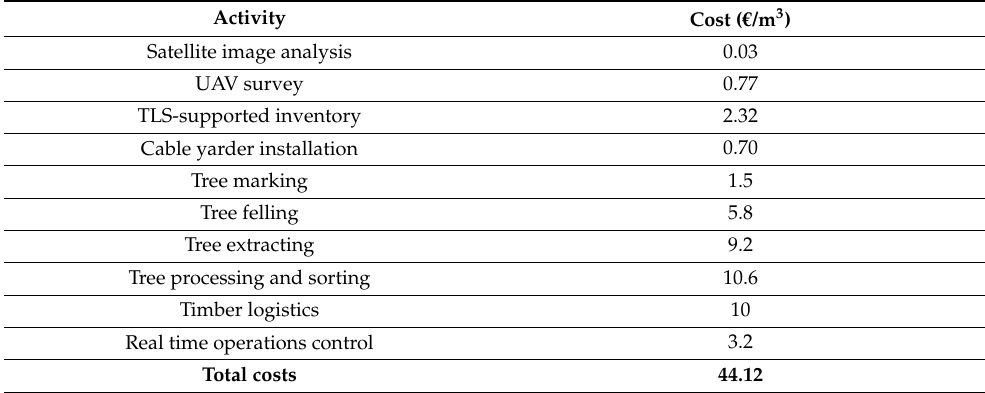
Table 10. Cost components and overall costs of the new timber tracking and processing